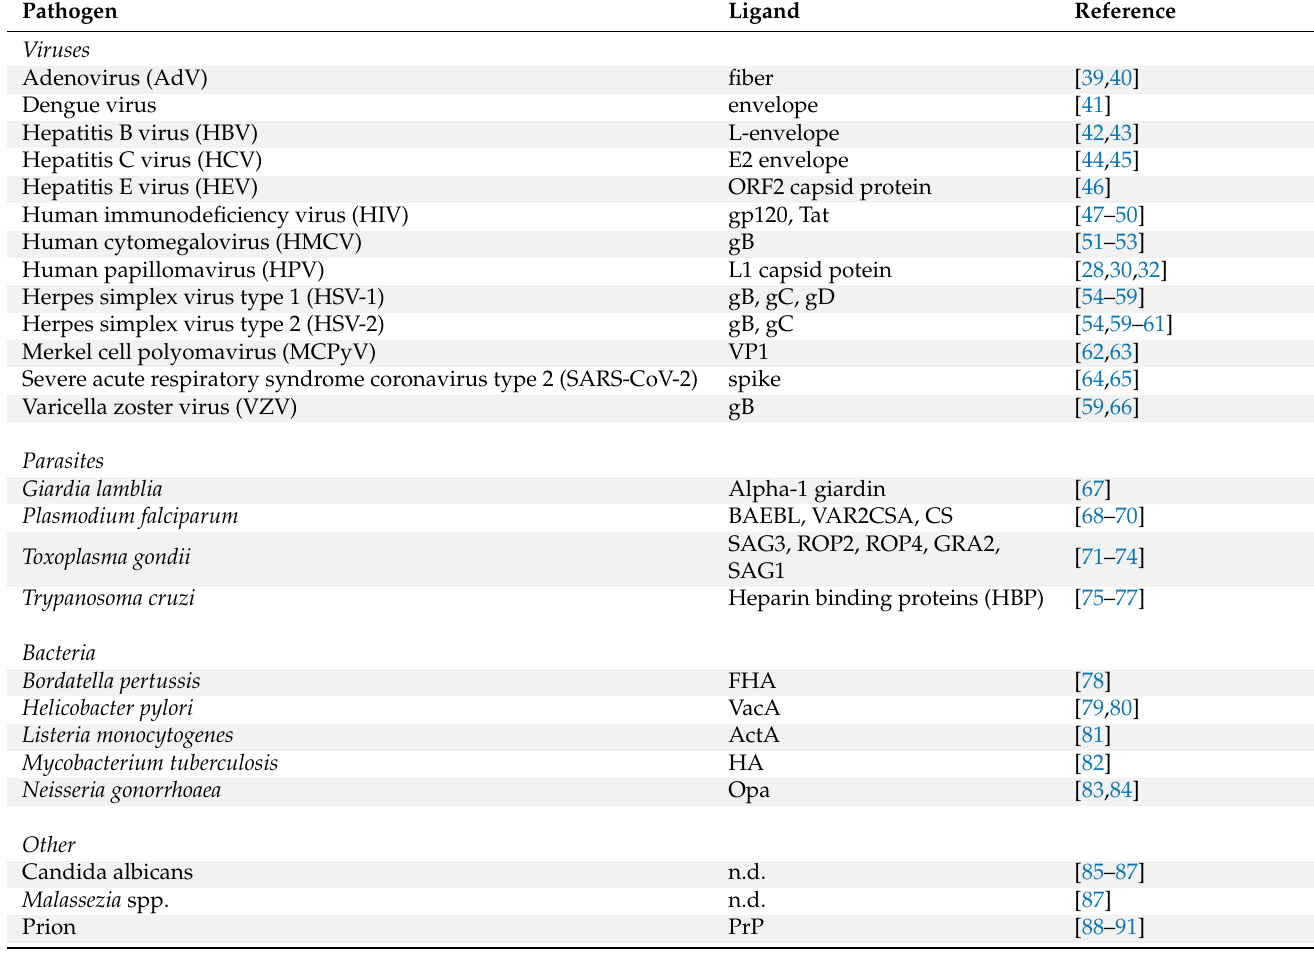
Table 1. Pathogens utilizing proteoglycans for host